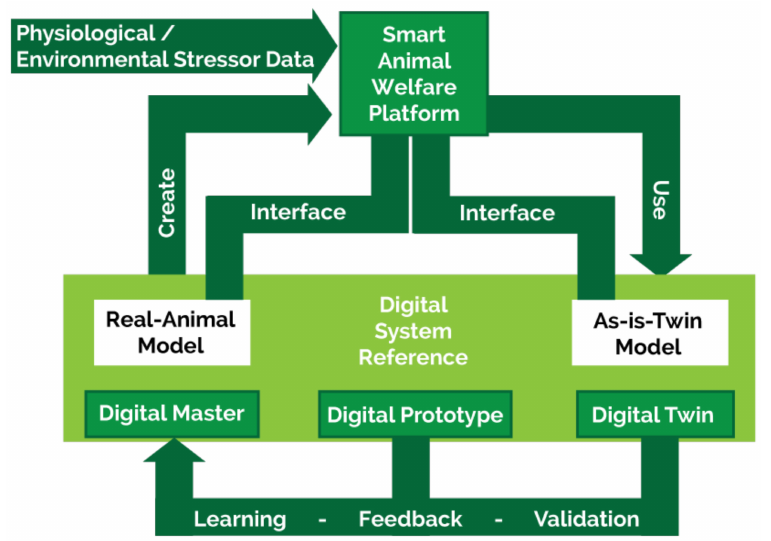
Figure 7. Digital Twin system reference architecture for smart animal welfare platform in predicting the behaviour of farm